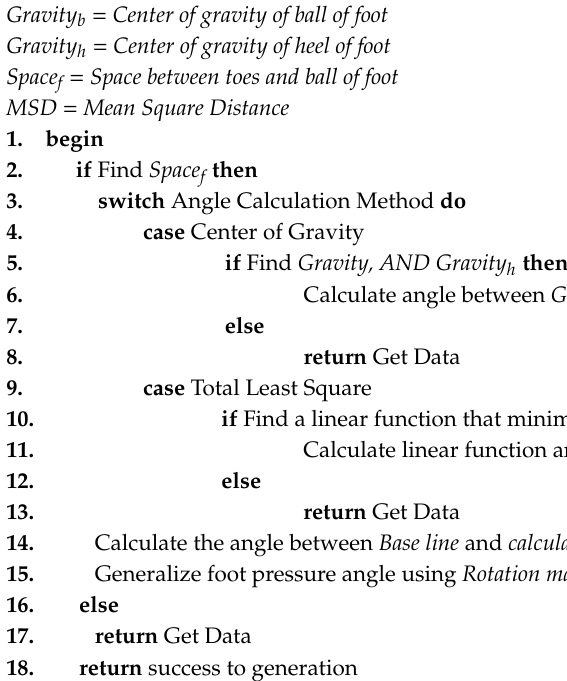
Algorithm 1. Pseudo code for generalization of pressure distribution. Gravity b = Center of gravity of ball of foot